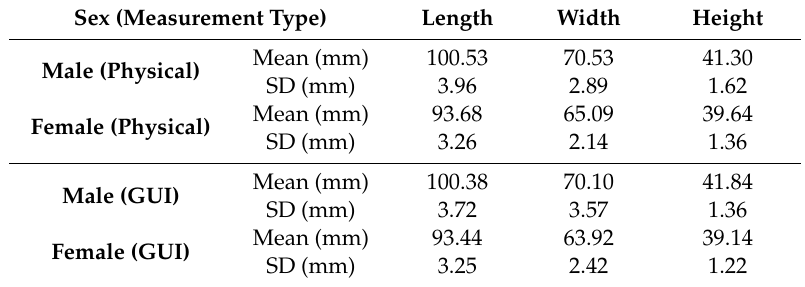
Table 1. Length, width, and height distance measurements of otter crania. Male crania are significantly larger than female crania via unpaired t -tests ( P < 0.001). Excellent agreement is seen between direct, physical and GUI-based results for these